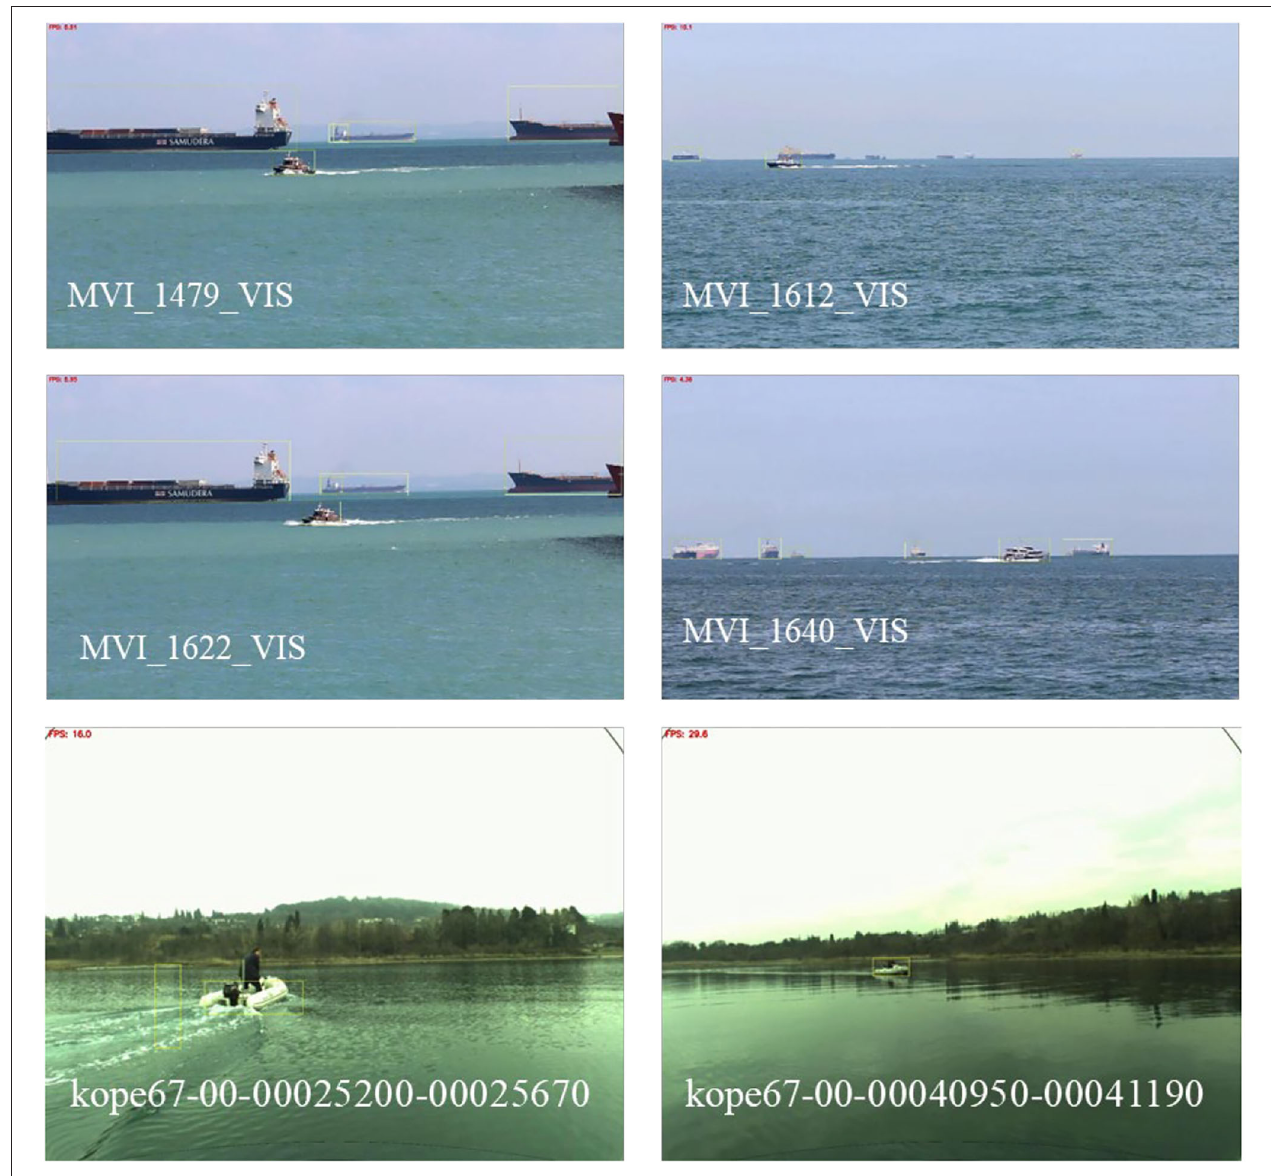
FIGURE 16 | Results of public